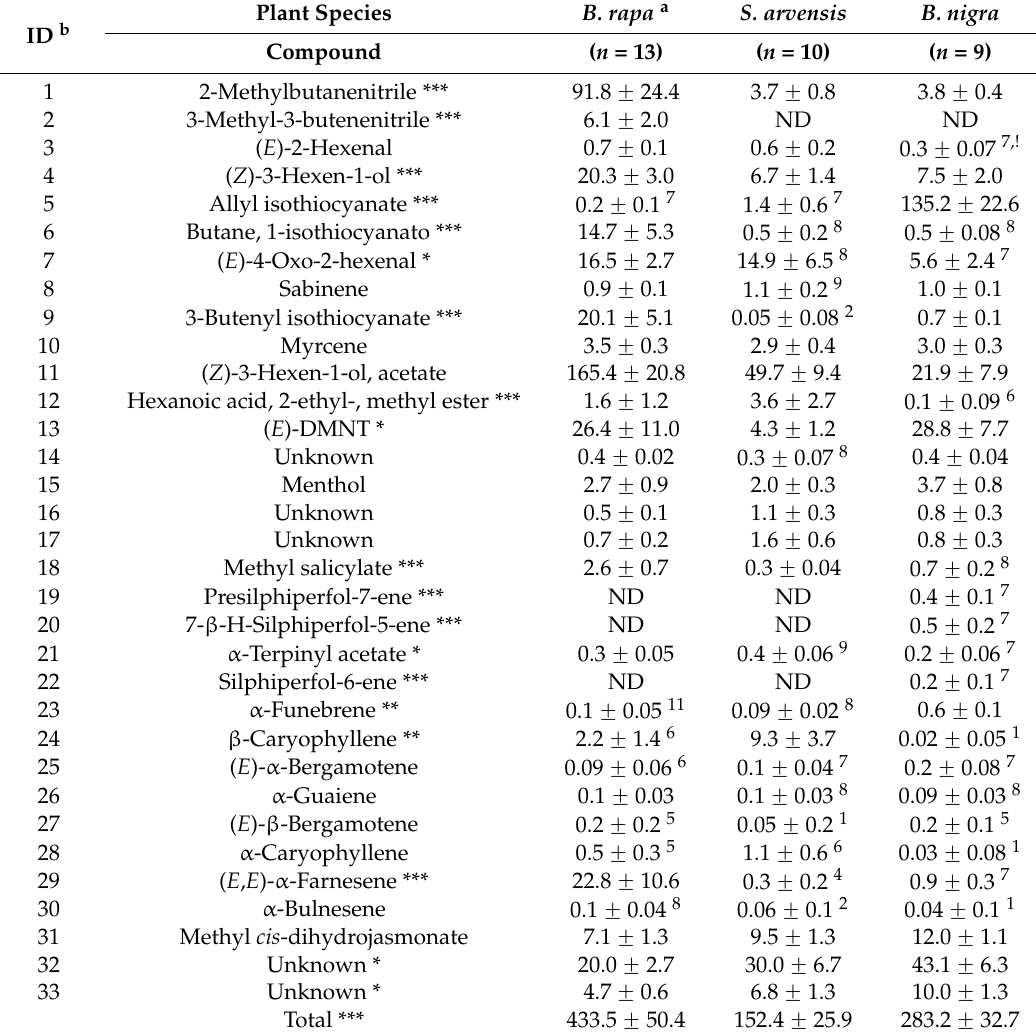
Table 1. Volatile compounds emitted by Brassica rapa , Sinapis arvensis , and Brassica nigra plants damaged by 20 first instar Pieris brassicae caterpillars for 24